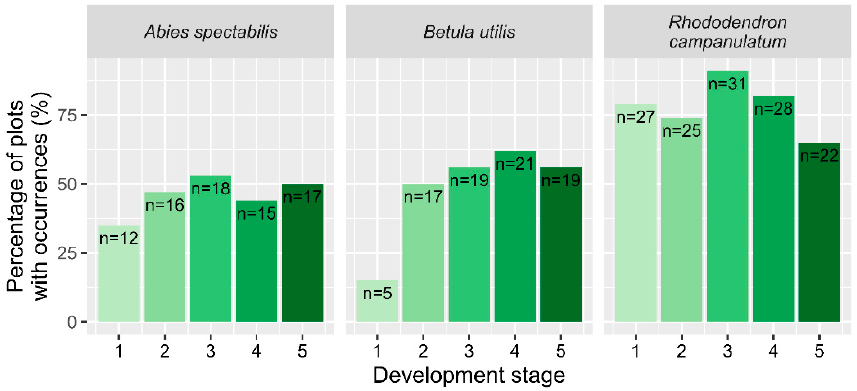
Figure 2. Percentage of plots with occurrence of the target species’ development stages (1: smallest seedlings, 5: adult trees). Numbers on bars show basic plot counts (total number of plots: n = 34).